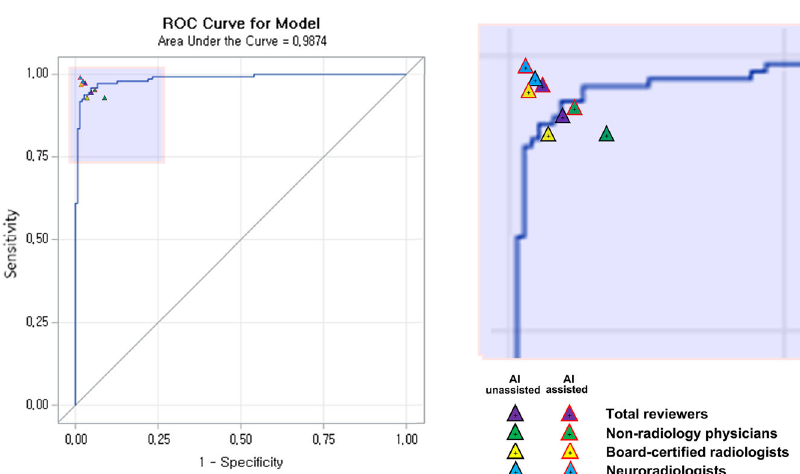
Fig. 1 Diagnostic performance of reviewers in terms of basic ROC curves for patient-wise AI standalone performance. In the reader assessment study, the AI-assisted group demonstrated signi fi cantly higher diagnostic accuracy in AIH detection compared to the AI- unassisted group in the patient-wise analysis (0.9703 [95% CI: 0.9632, 0.9765] vs. 0.9471 [95% CI: 0.9379, 0.9553], p < 0.0001). Based on subgroup analysis, non-radiologist physicians achieved the greatest bene fi t in terms of improvement in diagnostic accuracy with AI assistance relative to that for the AI-unassisted group (0.9505 [95% CI: 0.9340, 0.9638] vs. 0.9189 [95% CI: 0.8990, 0.9360], with an improvement of 3.15 [95% CI: 0.86, 5.45], p = 0.0072) for non-radiologist physicians to the level of radiologists without AI assistance (0.9459 [95% CI: 0.9290,